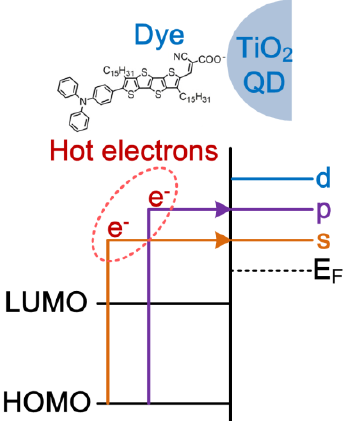
Figure 3. Hot-electron injection from dyes to the quantized energy levels of TiO 2 quantum dots (QDs).